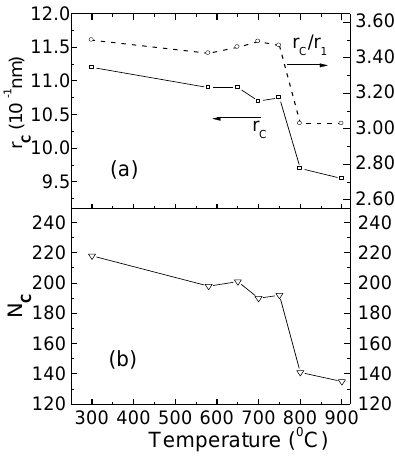
Figure 7. r C , N C and r C / r 1 of In-Sn80 versus temperature. ( a ) r C and r C / r 1 versus temperature; ( b ) N C versus